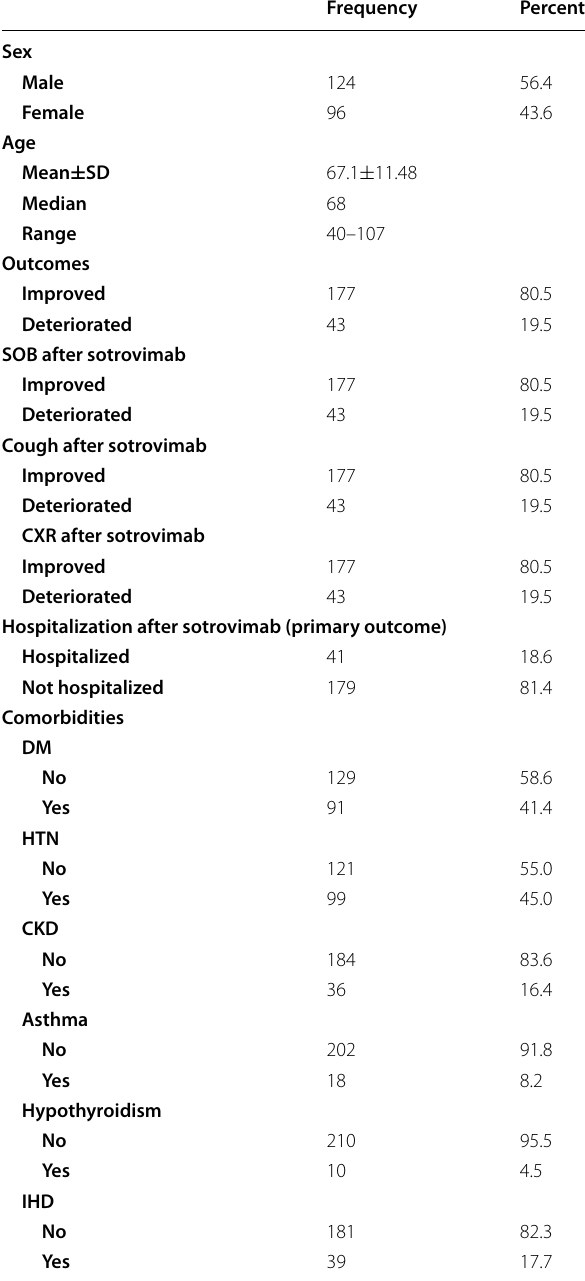
Table 1 Age, sex distribution, outcome, comorbidities, symptoms, and chest x-ray of the studied